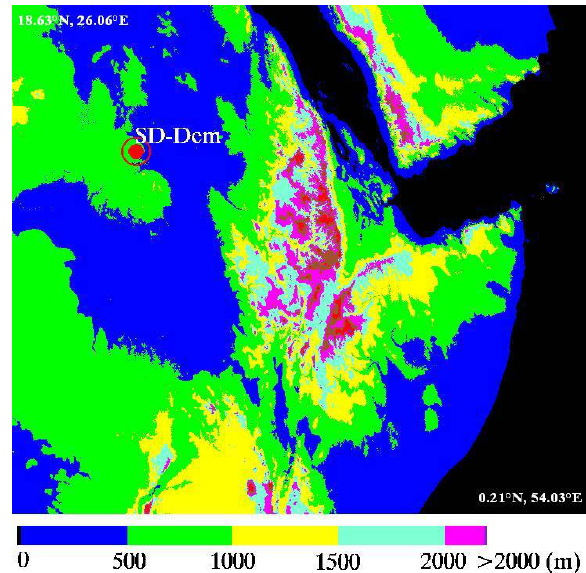
Fig. 1 . Elevation of the study region, and location of the SD-Dem validation site in Fig. 1. Elevation of the study region, and location of the SD-Dem Sudan. validation site in Sudan. Fig. 2 . Flowchart of the proposed methodology to estimate daily actual ET, daily Fig. 2. Flowchart of the proposed methodology to estimate daily reference ET, and daily dryness index. actual ET, daily reference ET, and daily dryness